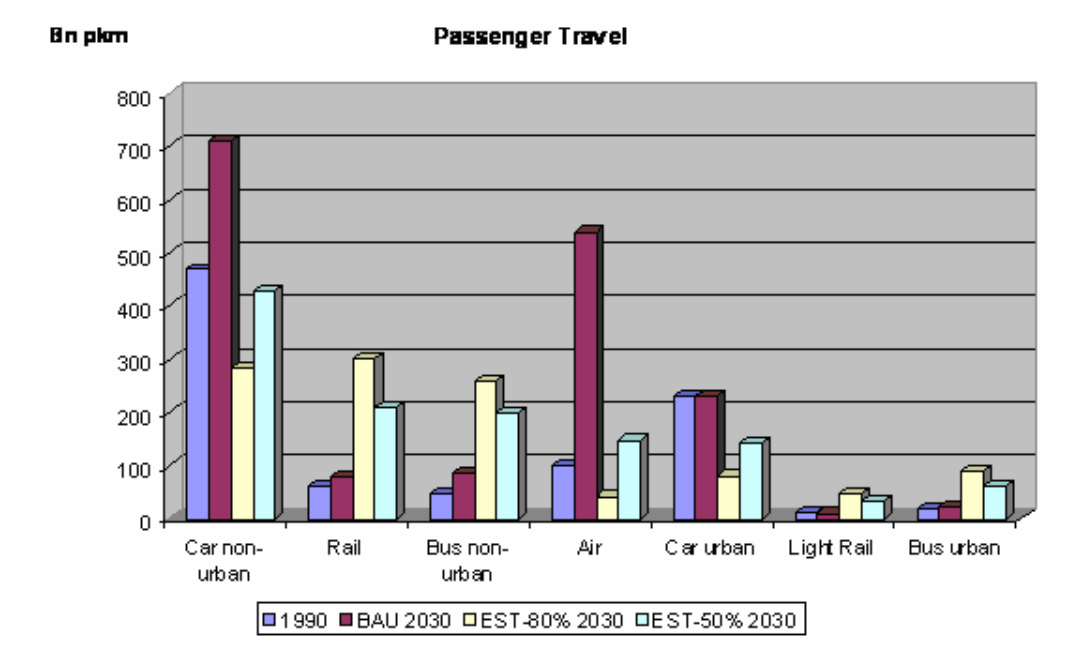
Figure 6. Comparison of Passenger Travel in 1990 and in 2030 for BAU, EST-80% and EST-